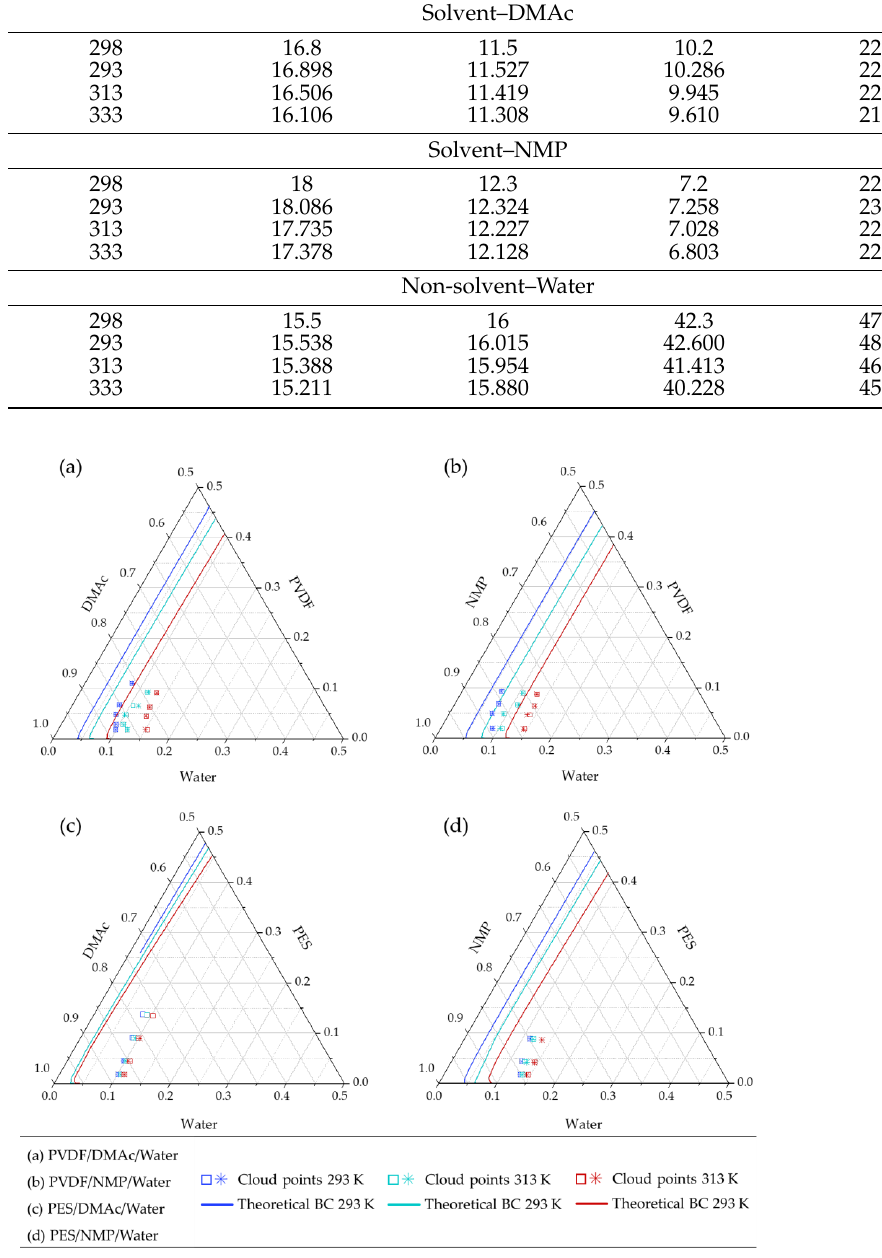
Figure A1. Cloud point and theoretical curves at 293, 313 and 333 K of ( a ) PVDF – DMAc – water, ( b ) PVDF – NMP – water, ( c ) PES – DMAc – water and ( d ) PES – NMP –water systems (α 13 = α 13 = 1 and χ 123 = 0).